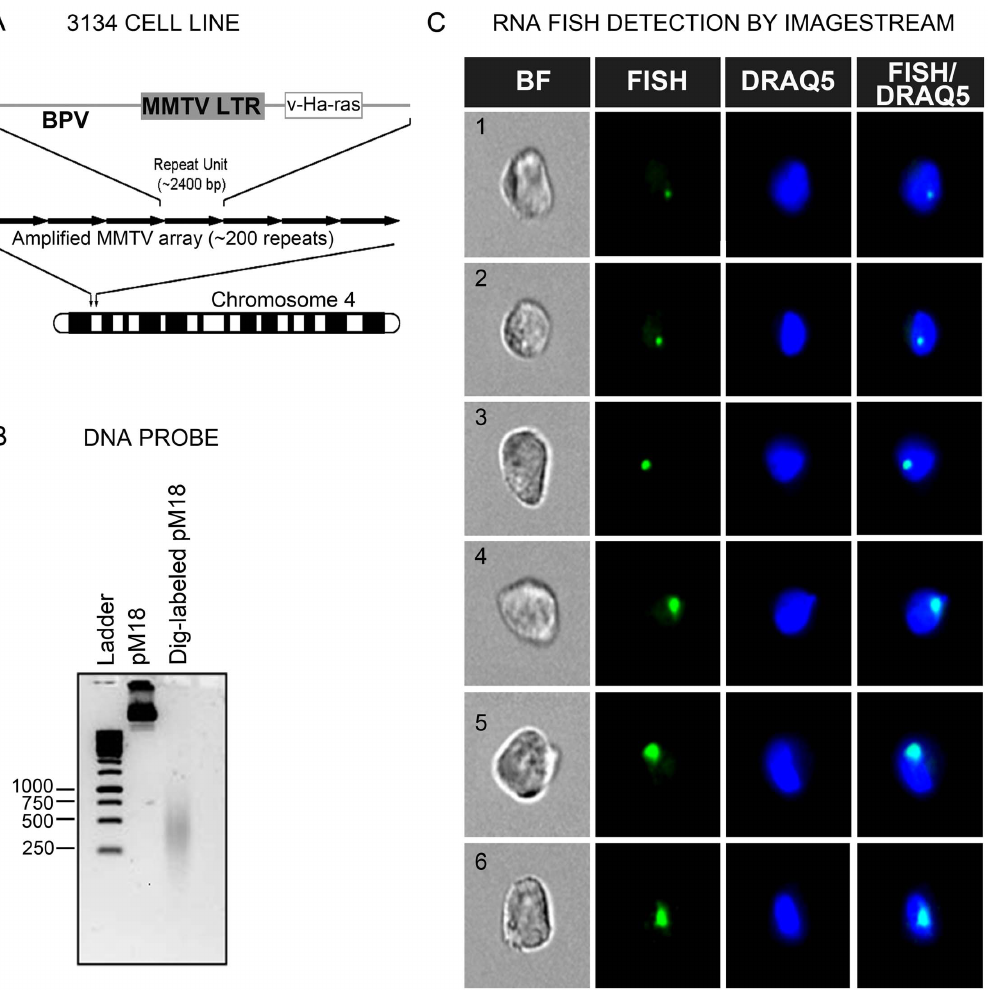
Figure 1. Automated detection of RNA FISH by imaging flow cytometry. (A) Organization of the MMTV-Ras transgene in the 3134 cell line. The 3134 cell line contains approximately 200 tandem repeats of MMTV-LTR driving viral Ras RNA on chromosome 4. (B) A Dig-labeled DNA probe was generated by nick translation of the pM18 plasmid containing the viral Ras coding sequence. Agarose gel electrophoresis revealed a DNA probe size within a 250–500 base pair range. (C) Imaging of cells following probe hybridization showed the presence of distinct nuclear FISH signals at a 40X magnification. The FISH signal was detected with anti-Dig secondary antibodies conjugated to a green-fluorescent dye. BF=Bright Field; DRAQ5=nuclear stain.